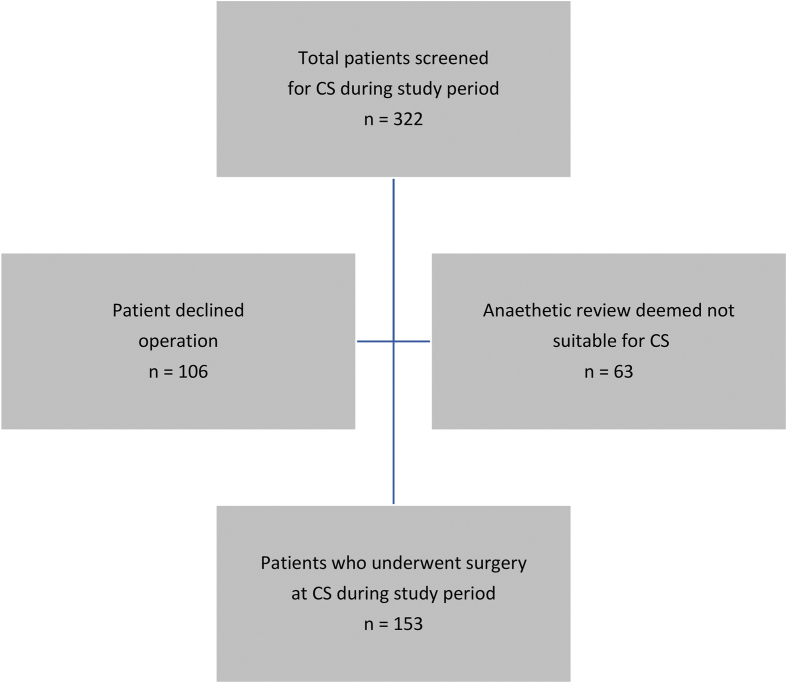
Patient selection.